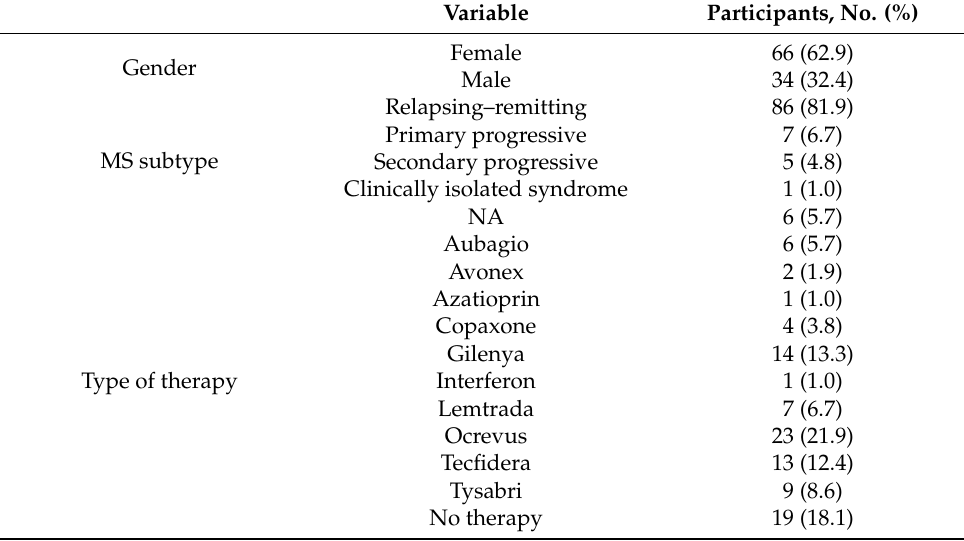
Abbreviation: MS = multiple sclerosis, NA = not available.